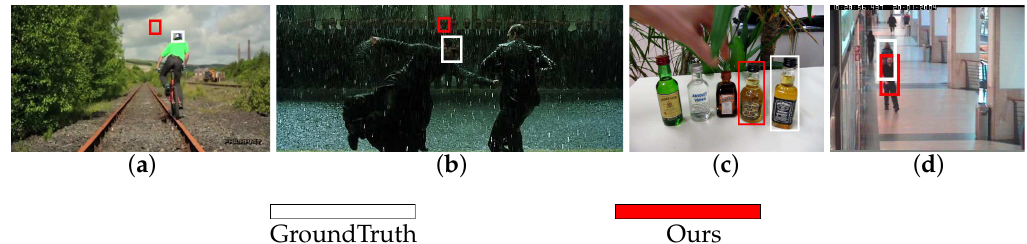
Figure 10. Failure cases on the following sequences: ( a ) Biker; ( b ) Matrix; ( c ) Liquor; ( d )